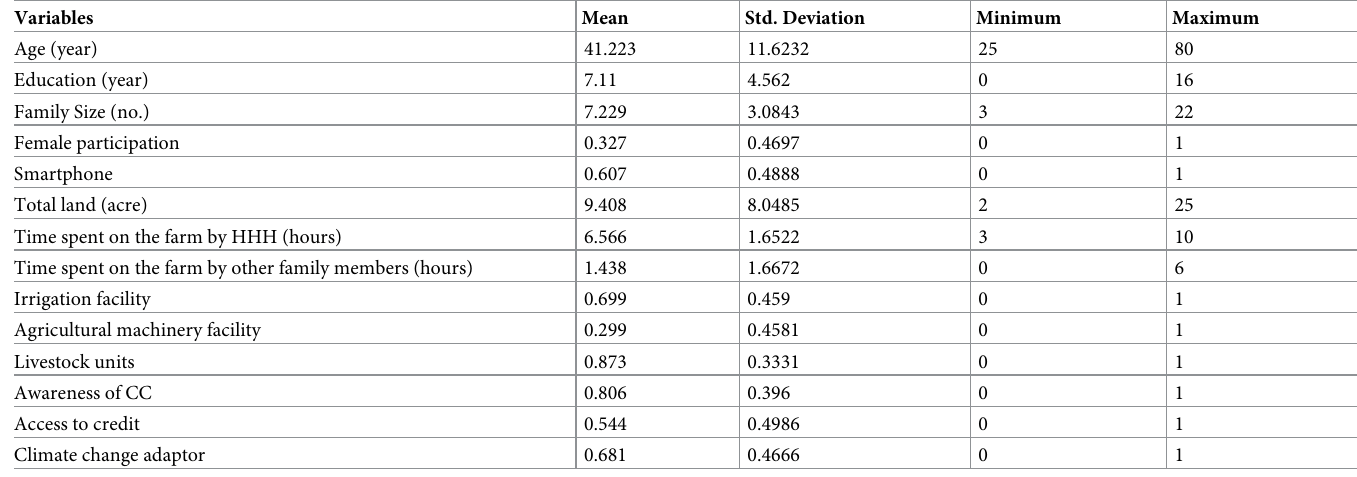
Table 3. Summary statistics of variables of interest.